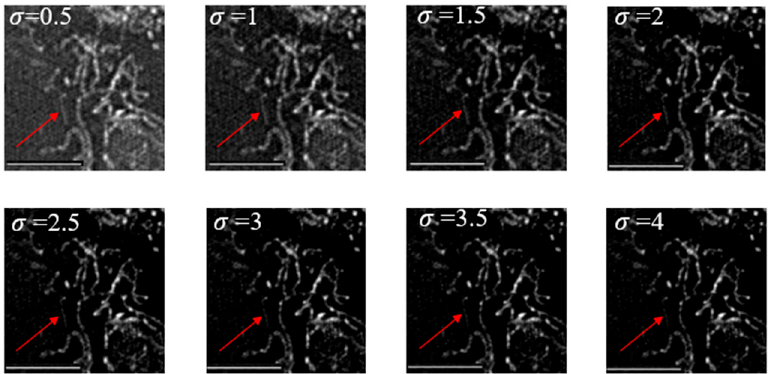
Figure 9. Under the 60× objective lens, when σ takes different values, N-SIM is used to reconstruct the image of mouse hepatocyte mitochondria. The length of the image scale is 5 μ m.